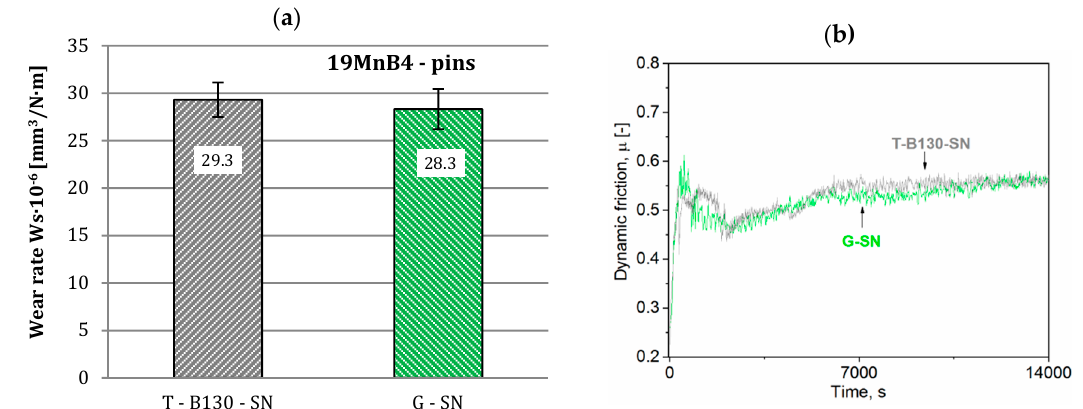
SN; 19MnB4 steel pins as counterbodies were used.